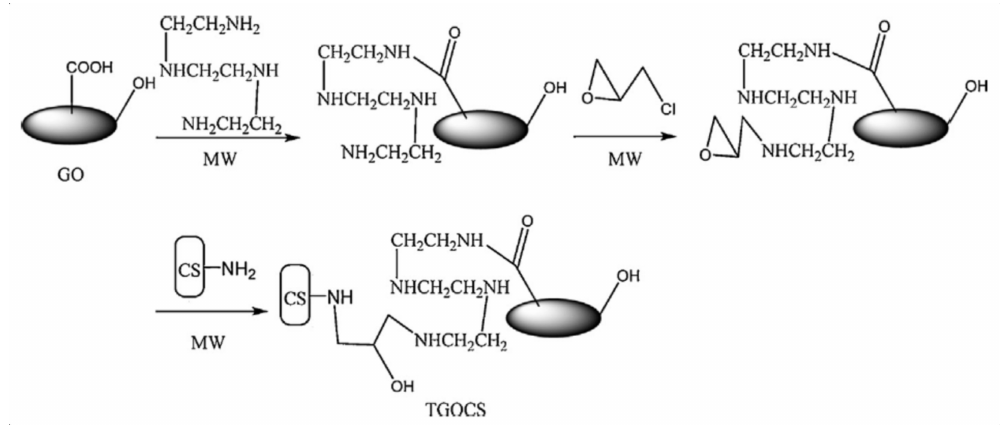
Figure 8. The synthesis of CS/GO composites (reprinted with permission from ref.